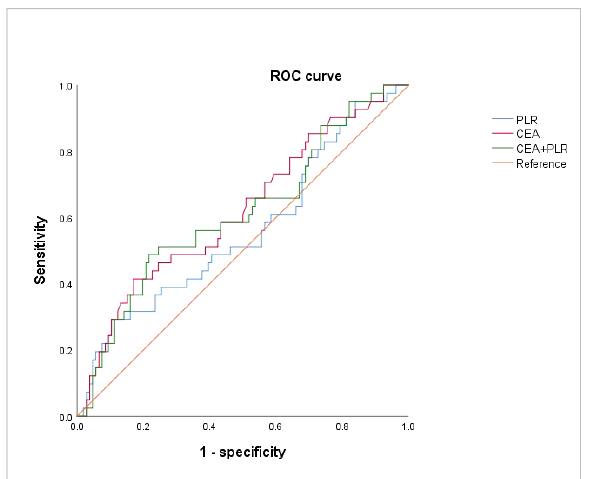
FIGURE 1 Receiver operating characteristic curves for analysis of using CEA and PLR in predicting disease-free